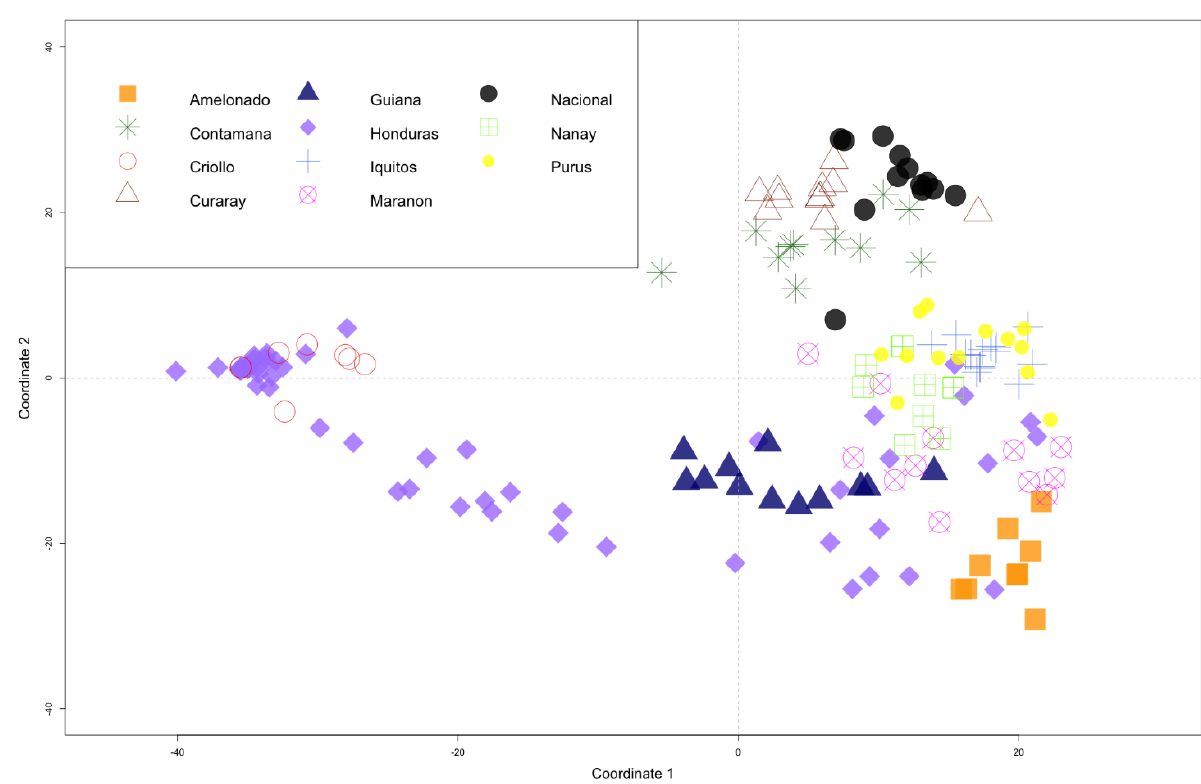
Figure 5. Principal coordinates analysis of the “Complete” dataset. The references accessions are divided based on the ten genetic groups [17], while all Honduran samples are identified by the same symbol to better visualize their wide distribution.